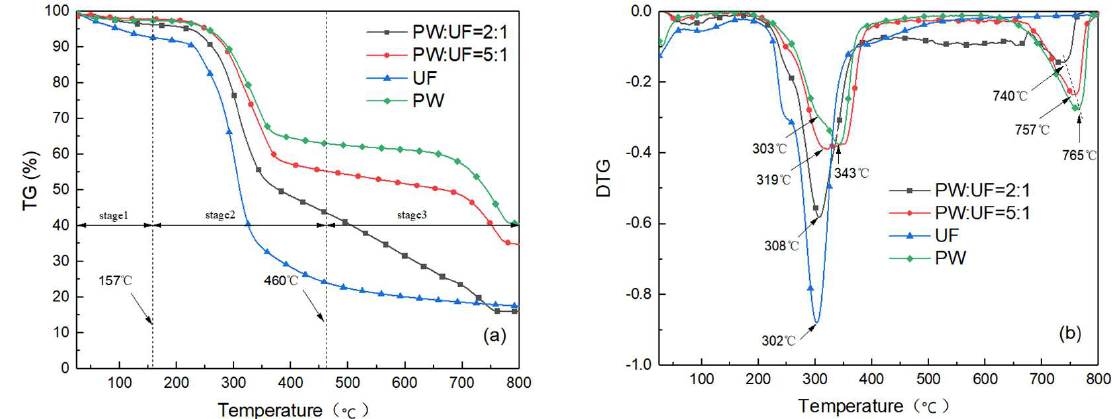
Figure 1. TG and DTG curves of pyrolysis. (( a ) TG curves; ( b ) DTG curves).